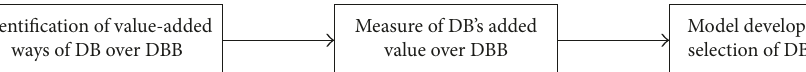
Figure 6: Steps of the preliminary design.